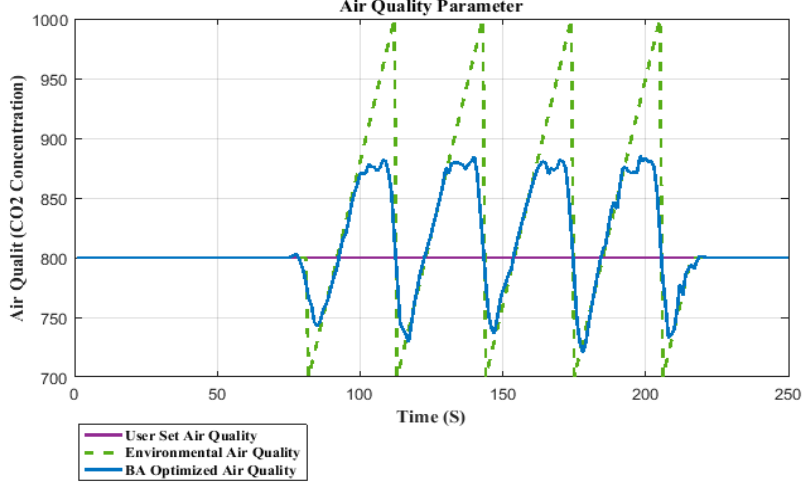
Figure 15. User set parameter; environmental parameter and BA optimize air quality values.